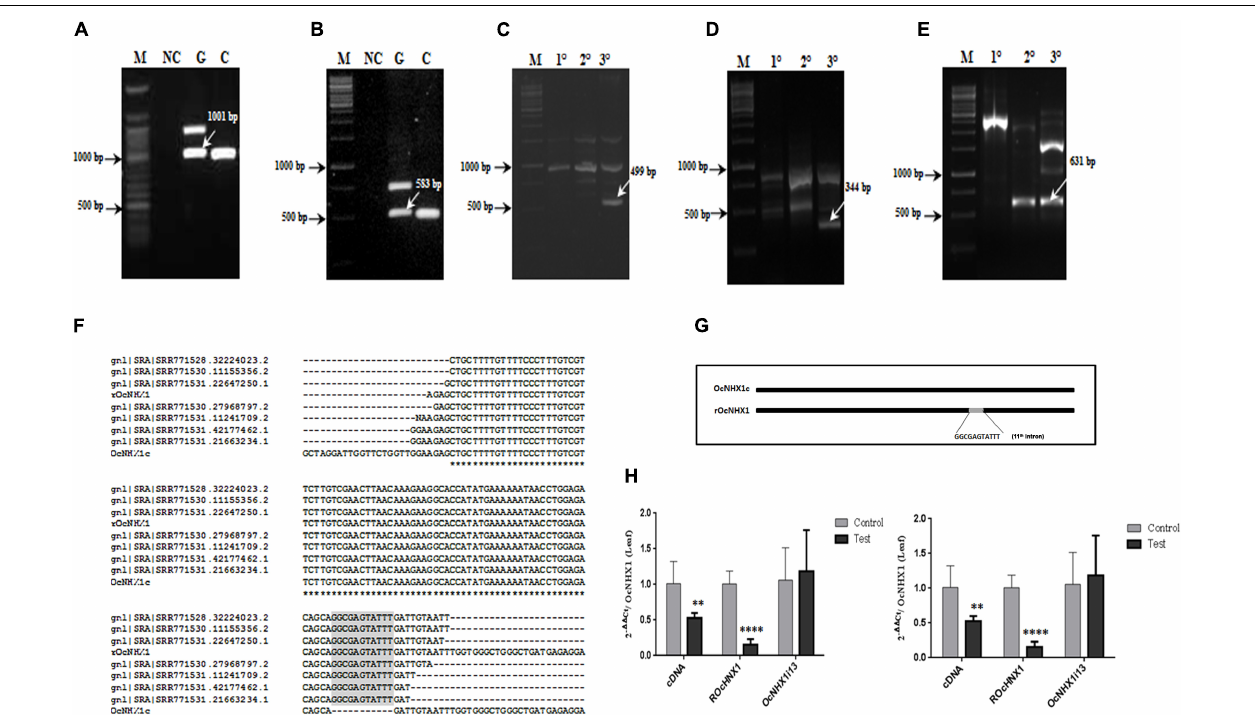
FIGURE 6 | Isolation of rOcNHX1 from O. coarctata . (A–E) A 2,032 bp size OcNHX1 retrogene ( rOcNHX1 ) was isolated from O. coarctata genomic DNA using a combination of genome walking techniques (also Supplementary Figure S1 ). (A,B) PCR with OcNHX1 specific primers and exon-exon junction primers used for gene isolation (1001 and 583 bp) (C) 499 bp fragment was isolated by Inverse PCR ( Xho I enzyme) using nested primers. (D,E) 344and 602 bp amplicons were isolated by nested PCR. M- DNA ladder; NC-Negative control; G- O. coarctata genomic DNA; C- O. coarctata cDNA; 1 0 – Primary PCR; 2 0 –Secondary PCR; 3 0 – Tertiary PCR. (F) rOcNHX1 differs from the OcNHX1 cDNA only in having (i) 11-bp insertion corresponding to the part of the 5 (cid:48) splice site of the 11th intron in the OcNHX1 genomic sequence (ii) 2 single nucleotide polymorphisms. (G) Analysis of the sequence read archive (SRA; O. coarctata transcriptome; Garg et al., 2013) confirmed the rOcNHX1 expression across stress treatments (450 and 700 mM NaCl, Submergence, Submergence + 450 mM NaCl). (H) qRT-PCR expression analysis of OcNHX1 splice variants in O. coarctata leaf and root tissues respectively under salinity. cDNA-correctly spliced OcNHX1 cDNA; rOcNHX1 : OcNHX1 retrocopy; OcNHX1i13- OcNHX1 splice variant with retention of 13th intron. Data presented is the mean of three biological replicates ( n = 3; with each replicate analyzed twice). Significance was calculated using one-way ANOVA (Student’s T -test). Statistical significance ( p -value) : * P < 0.05; ** P < 0.01, *** P < 0.001, **** P <